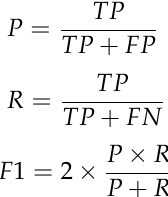
Figure 6. Confidence map generated with different 𝜎 values. ( a ) Ground truth of SDTs; ( b ) The confidence map when 𝜎 is 1; ( c ) The confidence map when 𝜎 is 2; ( d ) The confidence map when 𝜎 is 3. 3.2. Analysis of Oversampling Method Figure 7 presents the detection accuracy metrics in precision, recall, and F1 values changed with the oversampling rate 𝜃 when σ is set to 2.0. In general, we found that the oversampling strategy had a positive effect on overall accuracy. From Figure 7, we found that, with an increase in 𝜃 , recall and F1 values in- creased compared to the original training size ( 𝜃 = 1), while the precision value was higher than 98.8% and did not change much when 𝜃 increased. The most gain was achieved when 𝜃 was set to 1.6, which help to improve the recall value by 0.84 and F 1 value by 0.89. While 𝜃 is greater than 1.6, the growth rate of recall and F 1 value de- creased but is still greater than the original.